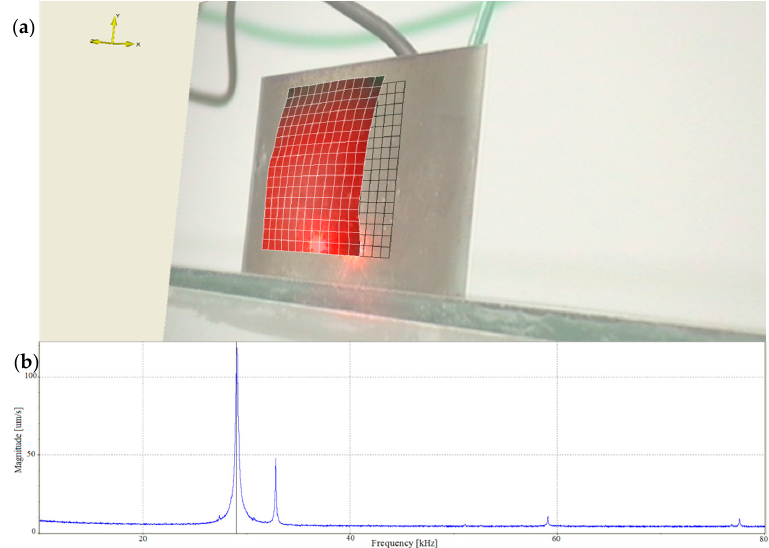
Figure 7. ( a ) The radial vibrational distribution on the side surface of the cylindrical transducer at the radial resonance frequency; ( b ) The frequency-radial vibrational velocity